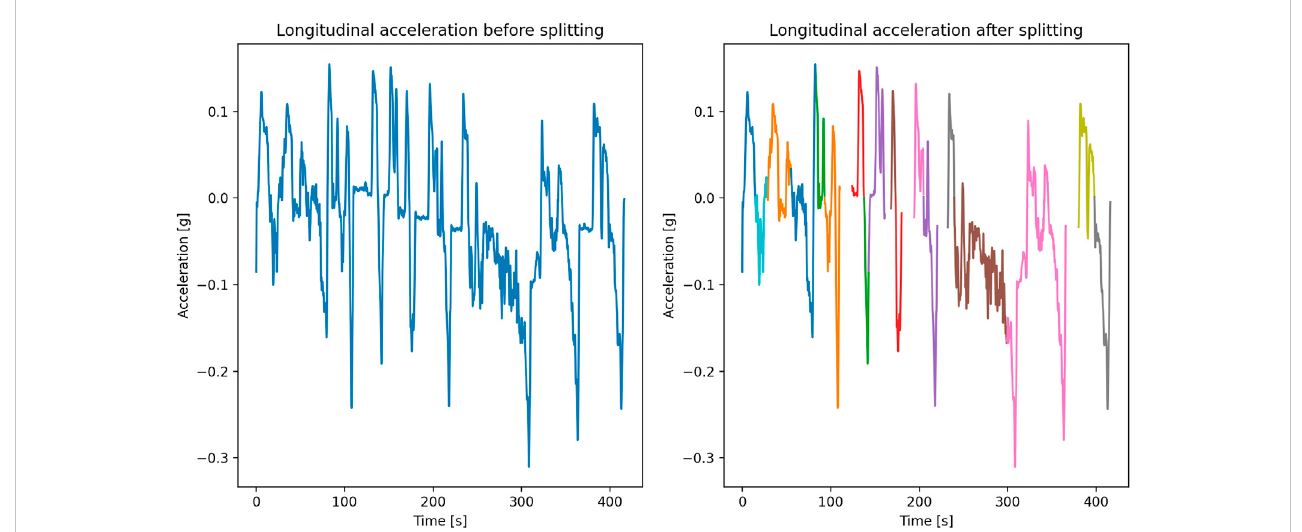
FIGURE 1 Example of a Butterworth fi ltered acceleration signal before and after splitting for ride no. 1 of an electric